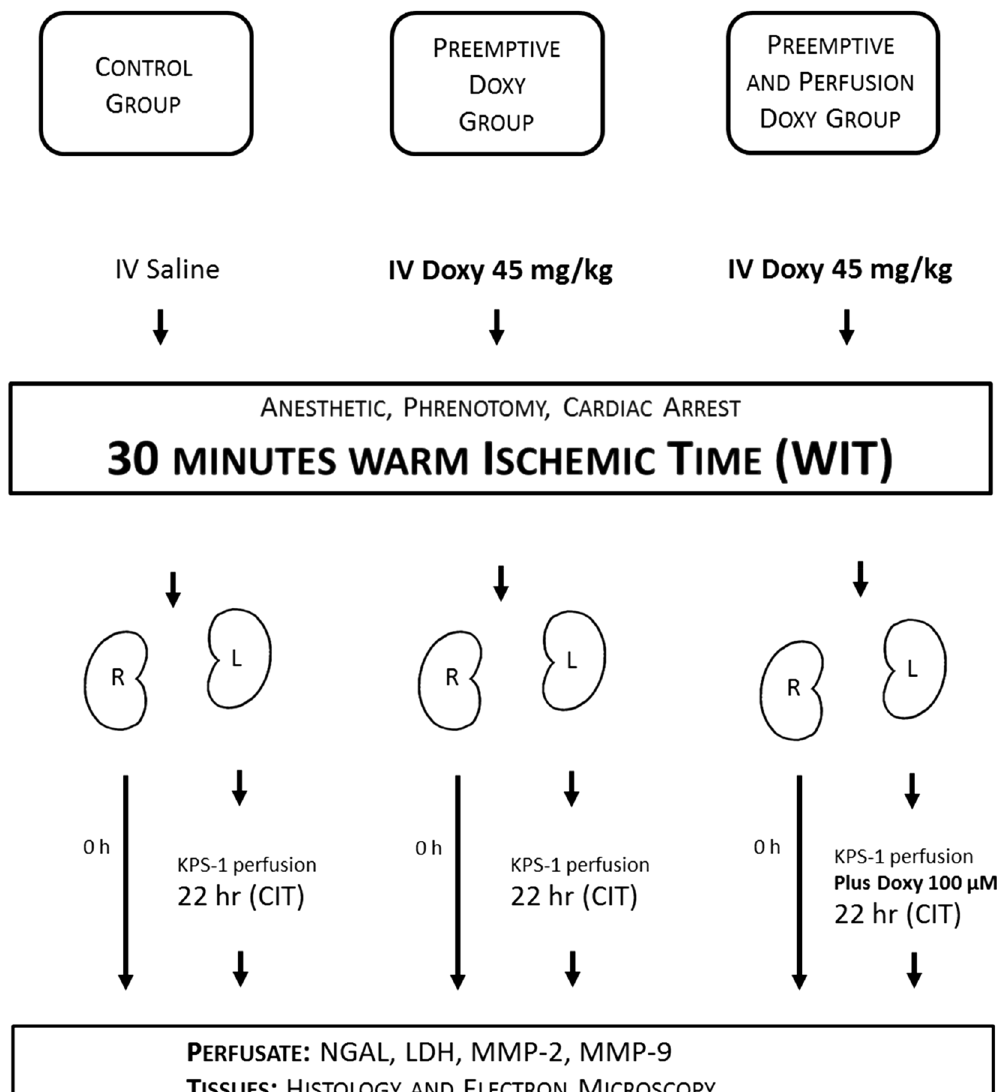
Figure 1. Study design, showing details of each of the 5 groups [2 right kidney groups to assess the effect of Doxy on warm ischemic injury (that is, with or without pre-arrest Doxy), and 3 left kidney groups to assess the effect of Doxy on warm and cold ischemic injury]. CIT: cold ischemic time, Doxy: doxycycline, KPS-1: Kidney Perfusion Solution-1, WIT: warm ischemic